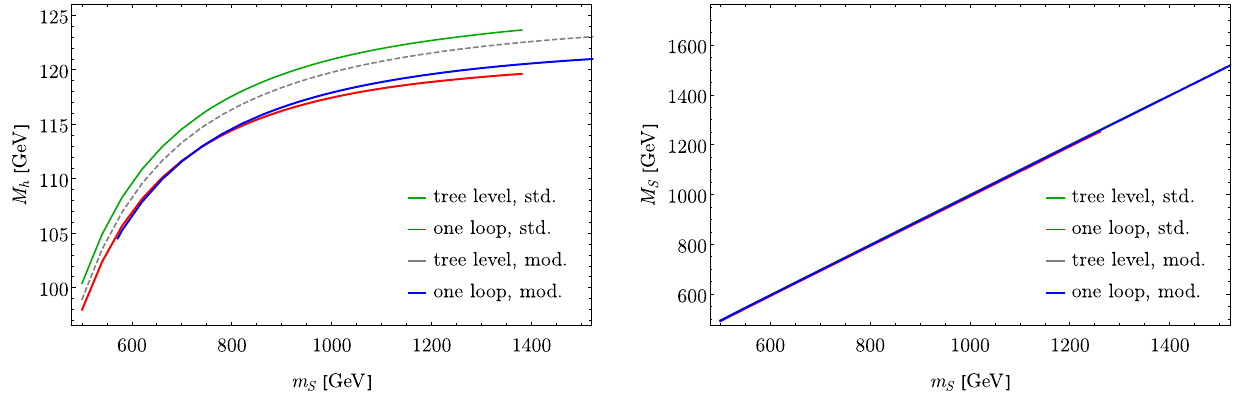
Fig. 7 M h (left) and M S (right) as a function of the true MS parameter m S in both the standard and modified schemes, where the standard scheme does not involve “consistent tadpoles” but the true MS mass m S is used everywhere. Other parameters as in Fig. 3